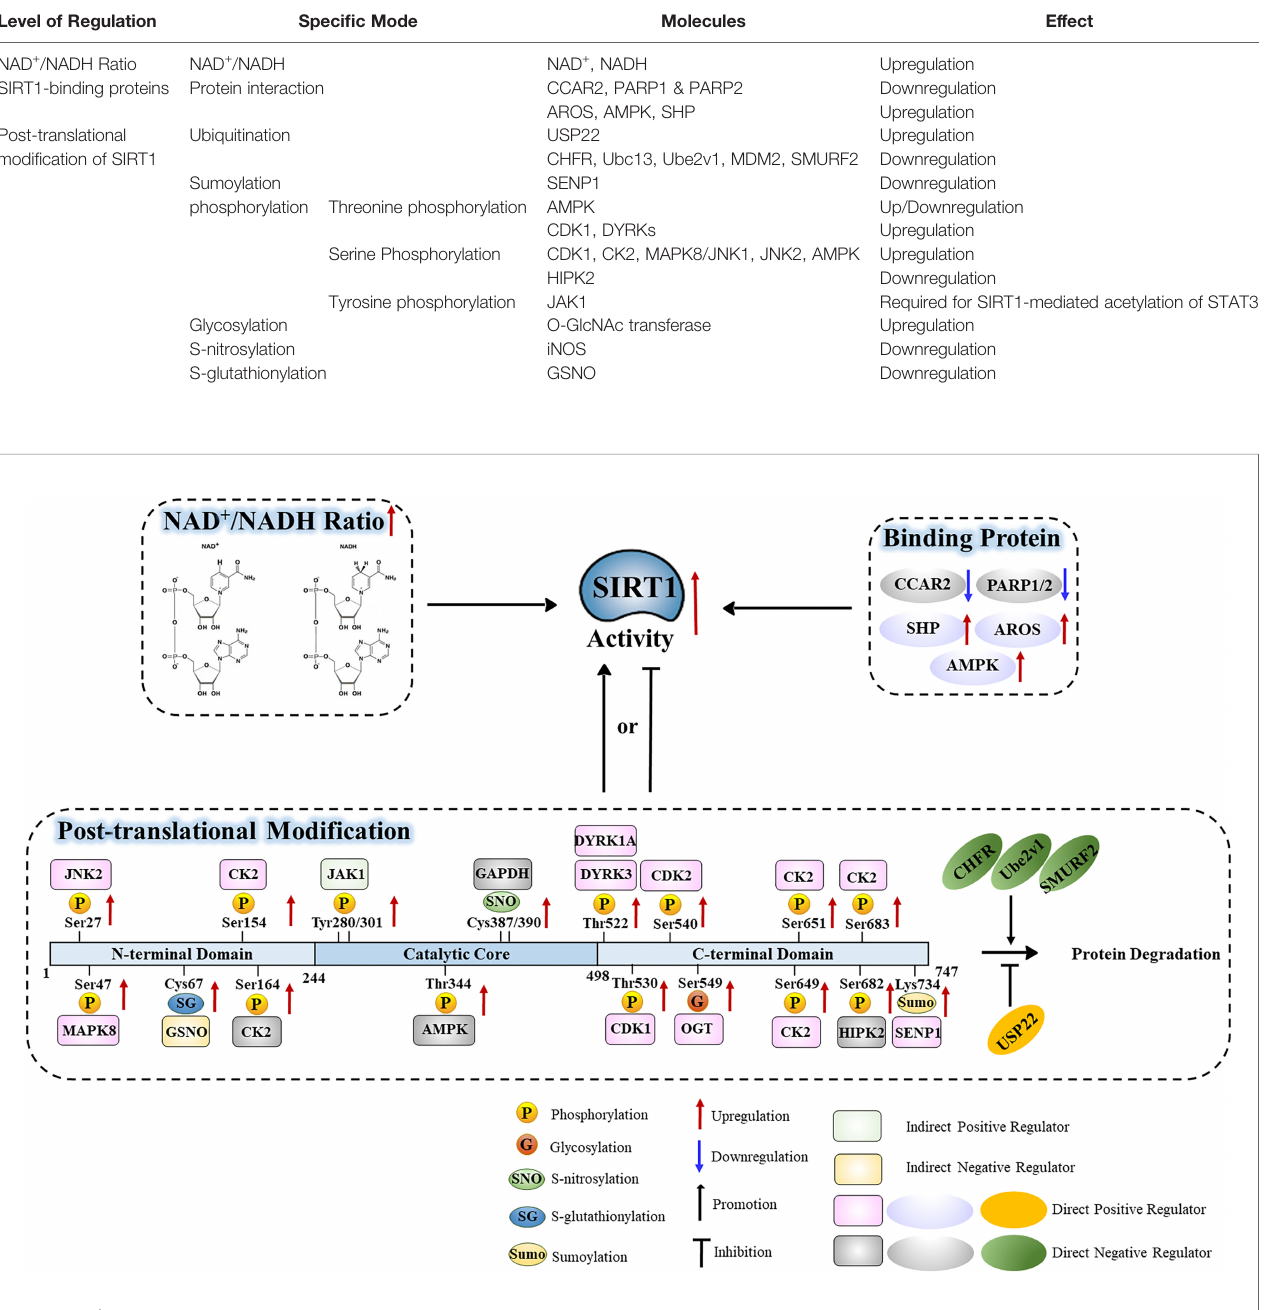
FIGURE 4 | Functional regulation of the SIRT1 protein in relation to the NAD + /NADH ratio, binding partners, and post-translational modi fi cations.